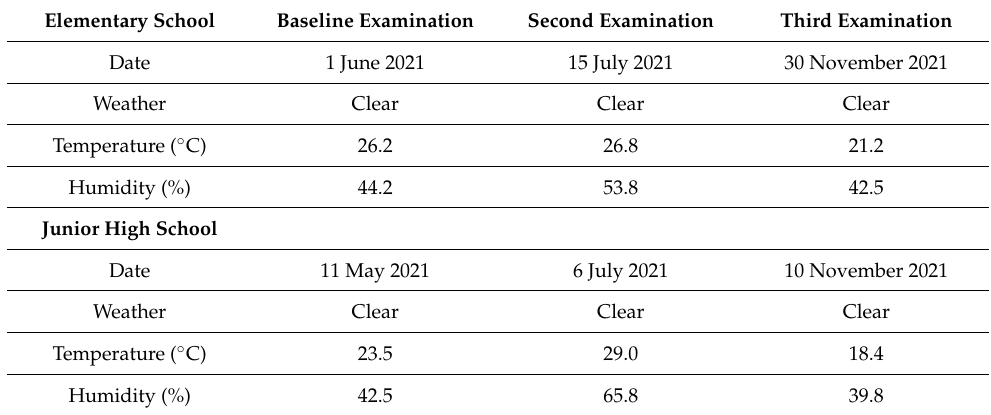
Table 1. Examination dates and